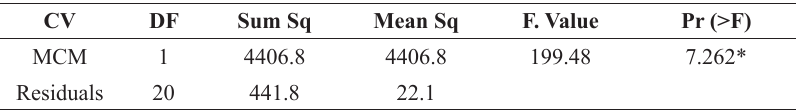
Analysis of the regression models of the MCM variable as a function of the CHTFM variable, performed in 22 test images (test